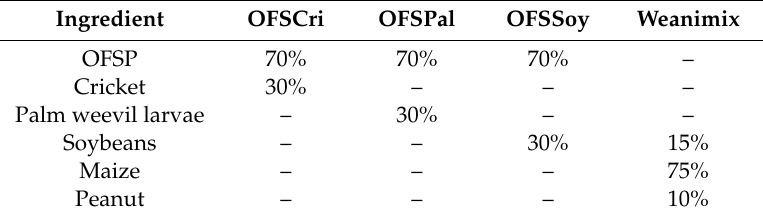
Table 1. Di ff erent proportions (%) of orange-fleshed sweet potato (OFSP), crickets, palm weevil larvae, soybeans, maize, and peanut used in the complementary foods. Ingredient OFSCri OFSPal OFSSoy Weanimix OFSP 70% 70% 70% – Cricket 30% – – – Palm weevil larvae – 30% – – Soybeans – – 30% 15% Maize – – – 75% Peanut – – –